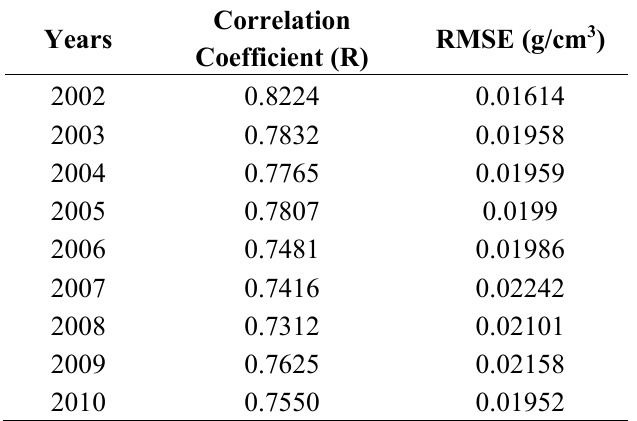
Table 2. The fitting parameters of the scatterplots in Figure